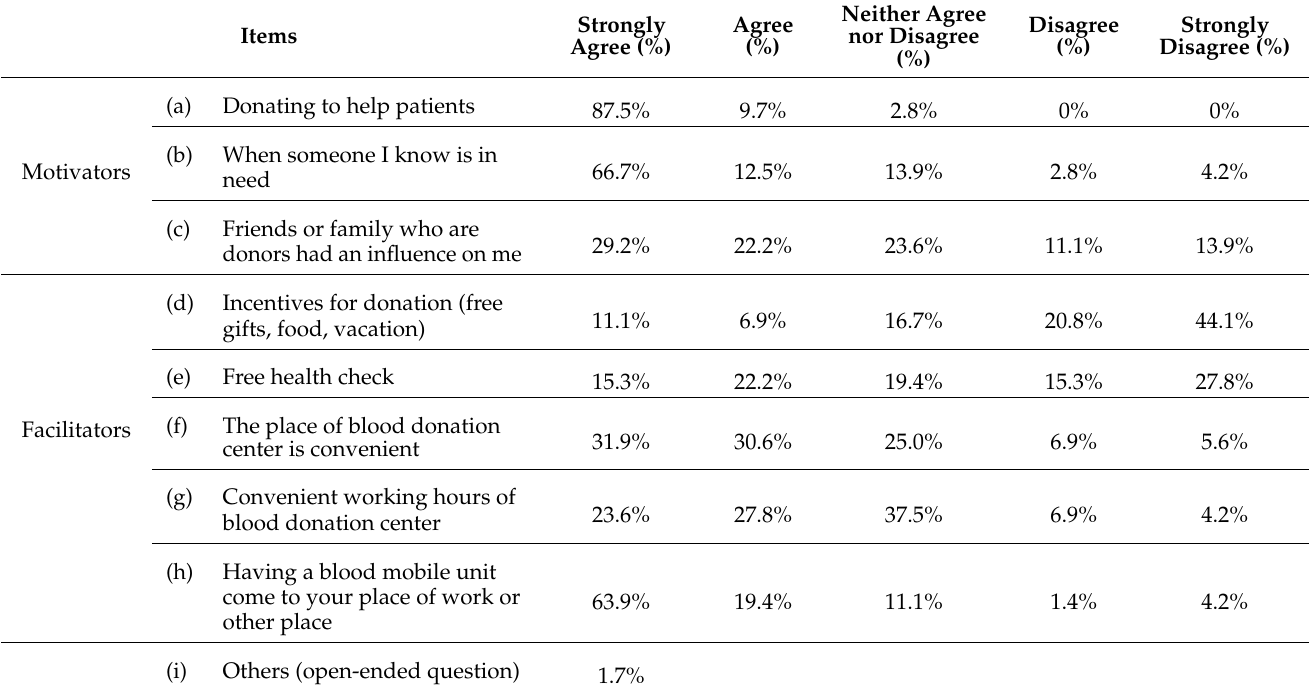
Table 3. Motivators/facilitators toward blood donation ( N = 72).